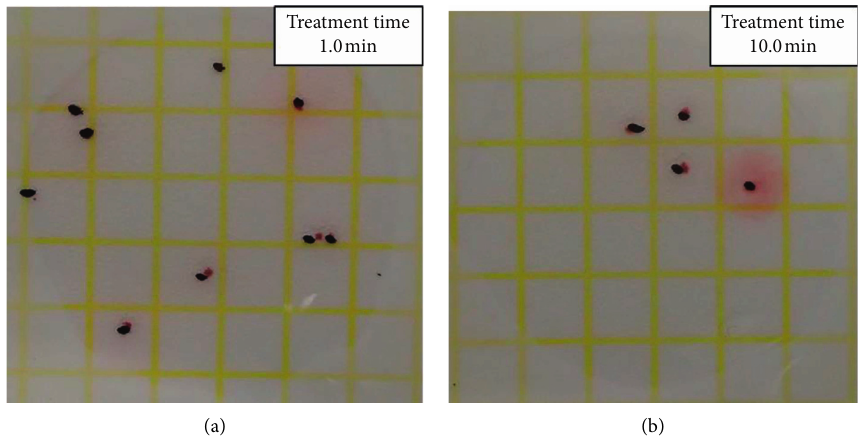
Figure 4: Picture of 3M ™ Petrifilm ™ AC Staph Express Count Plate (bacteria per gram) in mulberry. Treatment time: (a) 1.0min; (b) 10.0min.